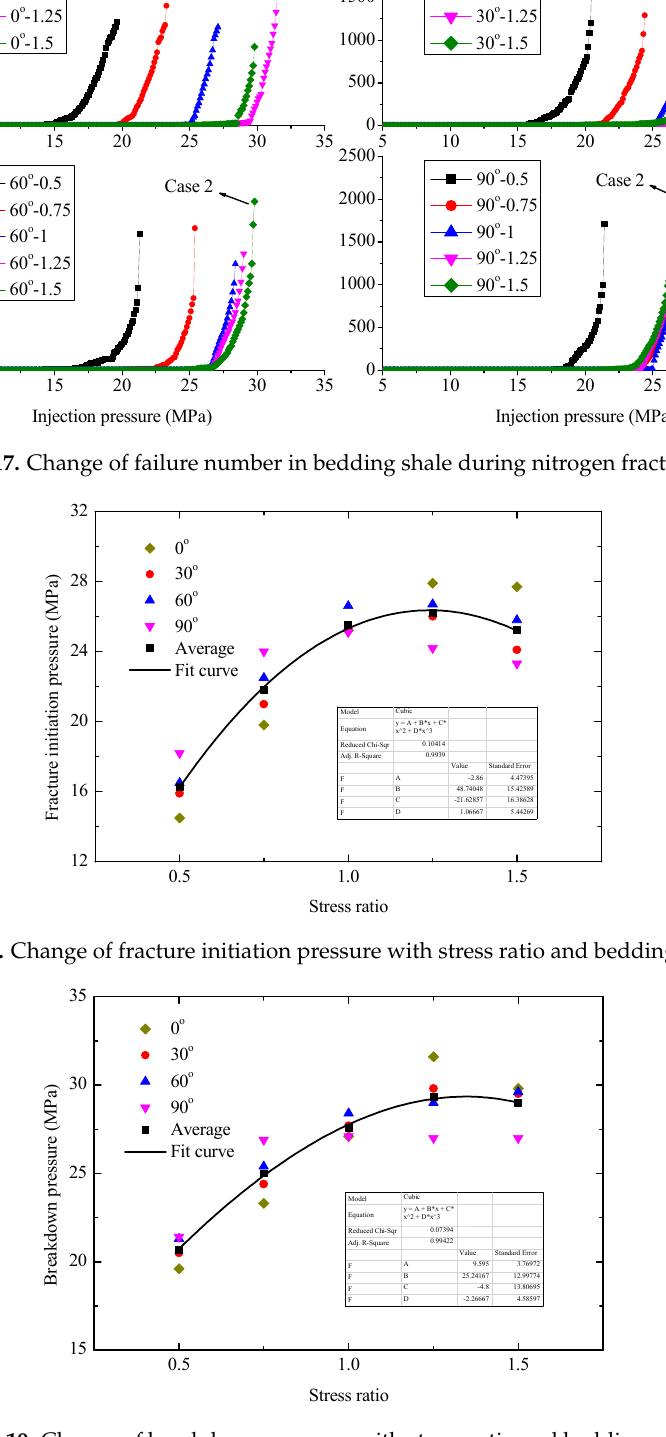
Figure 19. Change of breakdown pressure with stress ratio and bedding angle.